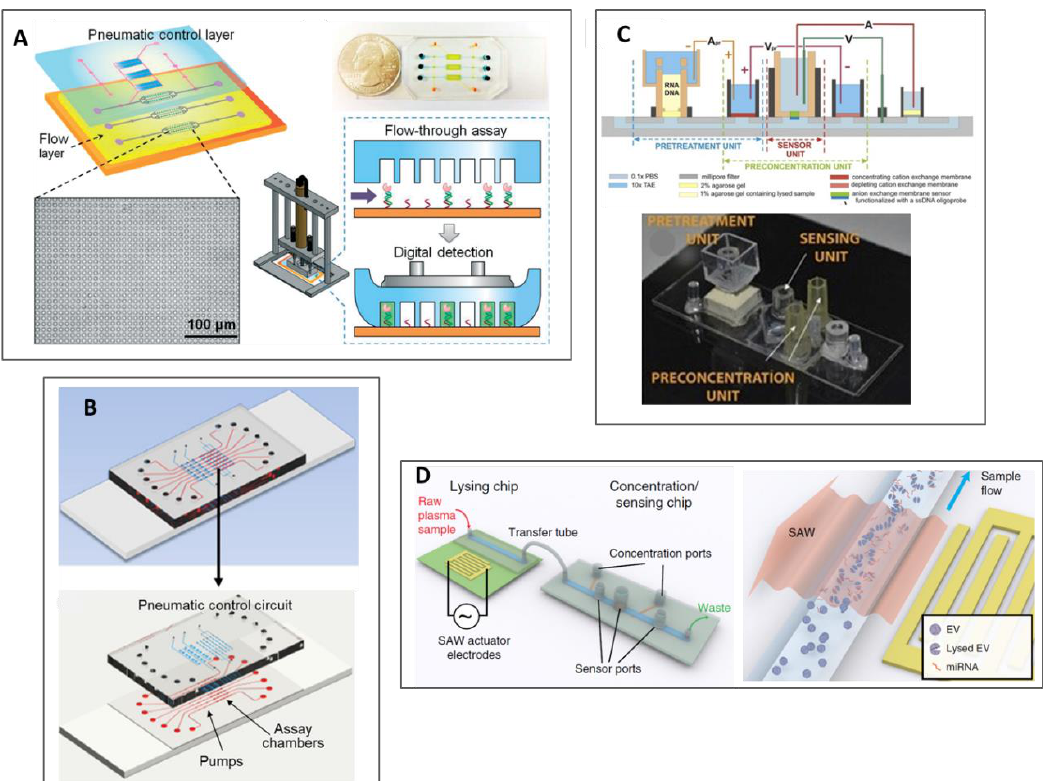
Figure 5. ( A ) Microwell-patterned microfluidic analysis chip. Reprinted with permission from [121]. Copyright (2018), Royal Society of Chemistry. ( B ) Schematic illustration of the assembled chip of the MERCA system for nucleic acid detection. The microfluidic chamber is functionalized with probes to capture target miRNAs; (bottom) design of the MERCA chip. The three-layer PDMS/glass chip integrates seven units working parallelly, consisting of an assay chamber with a three-valve pump. Reprinted with permission from [123]. Copyright (2019), Science Direct. ( C ) Microbiochip integrating a unit for nucleic acid extraction, preconcentration and sensing. Reprinted with permission from [124]. Copyright (2015), Elsevier. ( D ) Principle of detection and chemical-free lysis of exosomes for an integrated microfluidic platform for miRNA analysis. Licensed under CC BY-NC 4.0 International